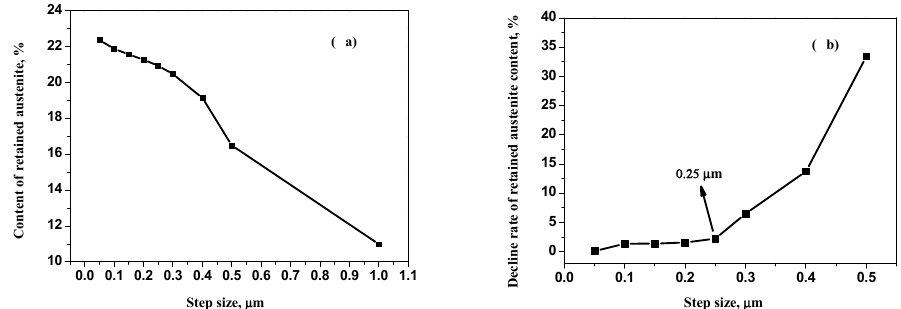
Figure 6. Curves of the measured retained austenite content ( a ) in TRIP780 steel and its decline rate ( b ) with step size.